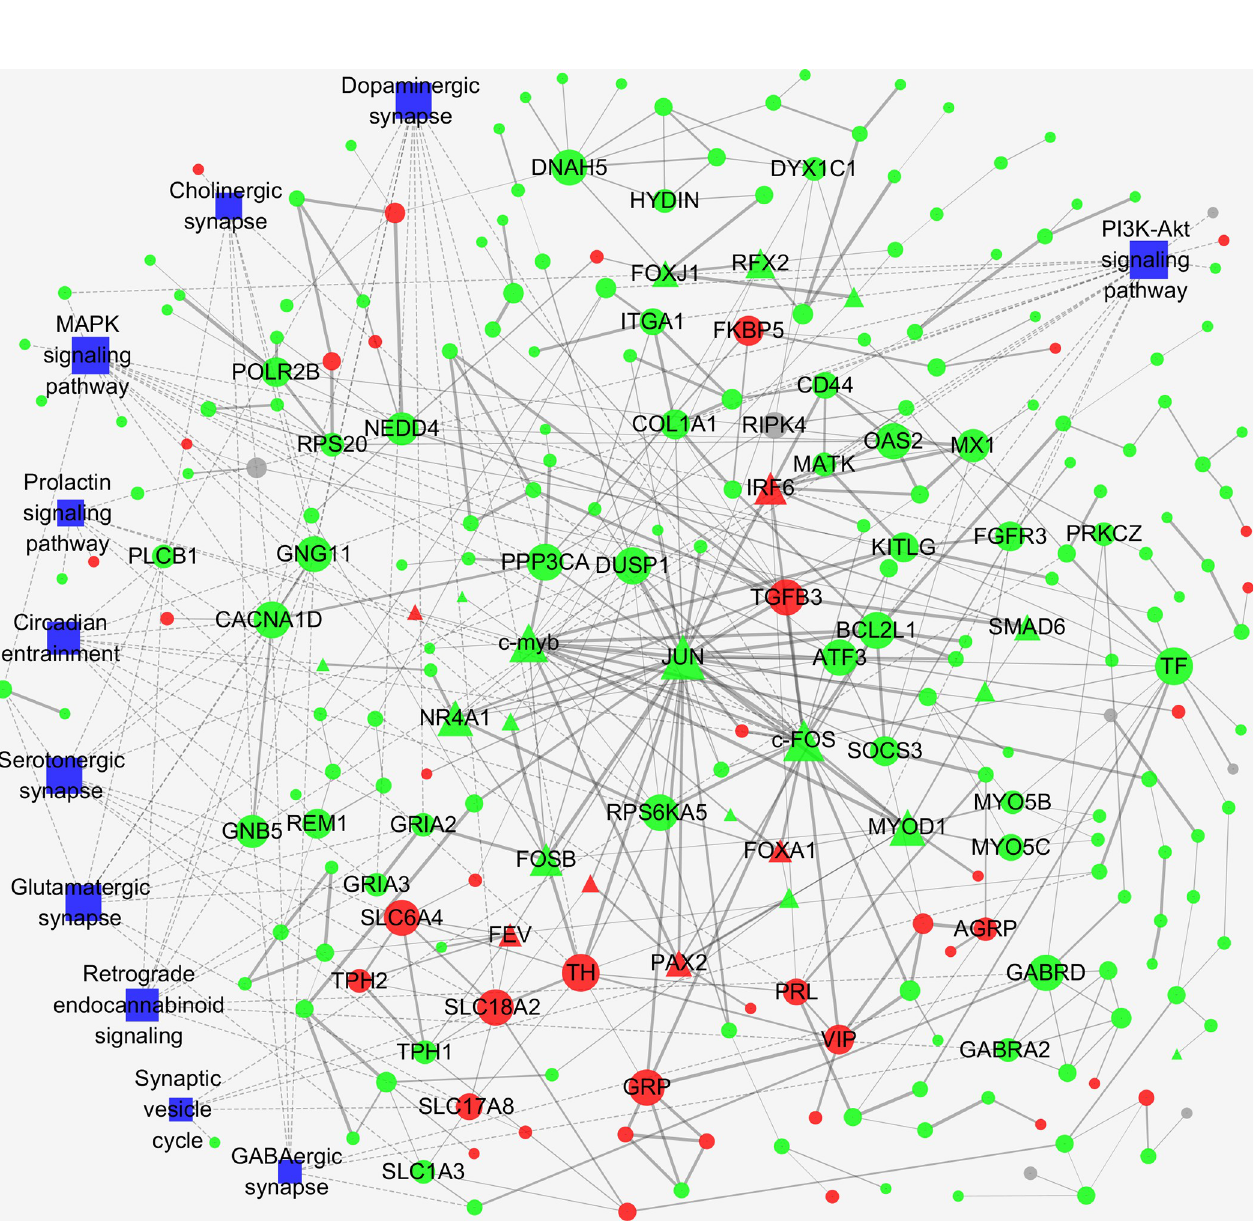
Fig 5. Protein-protein interaction (PPI) networks of DEGs. Circle nodes for genes/proteins, pentagon for transcription factors, rectangle nodes for KEGG pathway or biological process. Nodes with a degree of connectivity greater than 5 were labeled and all nodes in S1 Fig were labeled. According to trend analysis, genes/proteins were colored in red (Cluster 1, representing up-regulation over time), green (Cluster 2, representing down-regulation over time) and gray (Cluster 3, gene expression changed in BP stage only). Interaction were show as solid lines between genes/proteins, edges of KEGG pathway/biological process in dashed